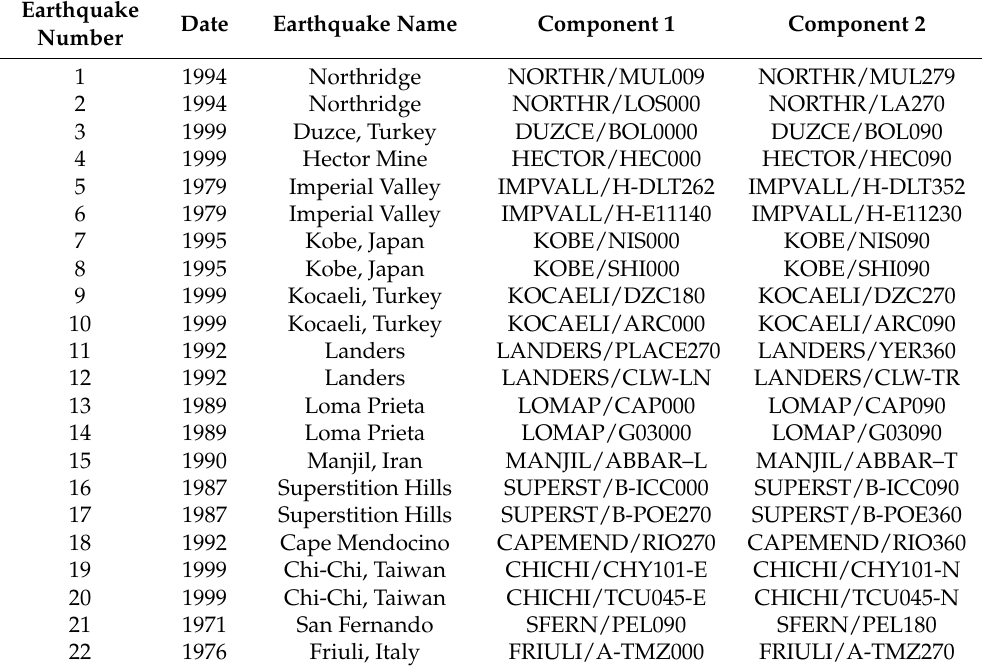
Table 1. FEMA earthquake records list.